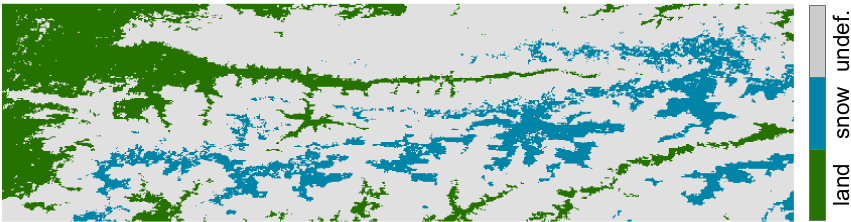
Figure 5. Temporally persistent spatial snow (MP s = 1) and land (MP l = 1 ) patterns for April in the study area shown in Fig. 1b. Pixels with “undef” indicate MP s < 1 or MP l < 1, for which classification is not possible in this step.